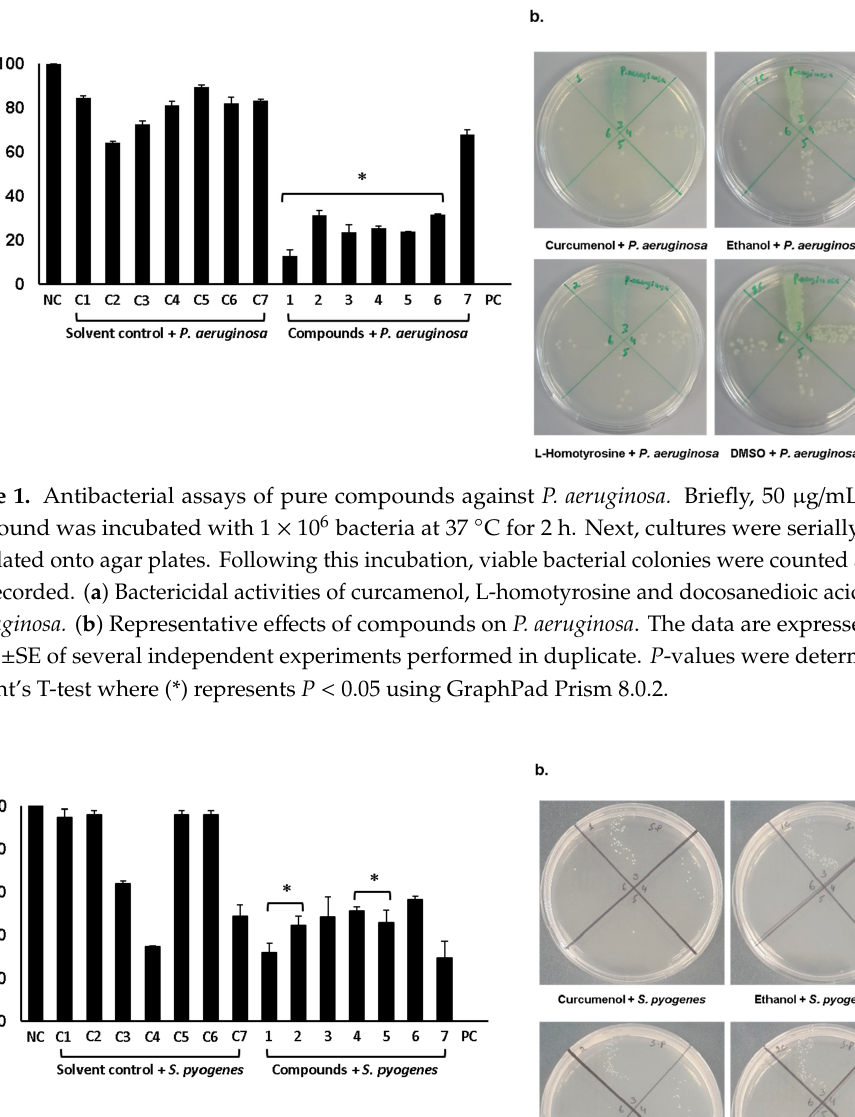
Figure 2. Antibacterial assays of pure compounds against S. pyogenes. Briefly, 1 × 10 6 bacteria were exposed to 50 µ g / mL of each compound at 37 ◦ C for 2 h. After this, cultures were serially diluted, plated onto agar plates and plates were incubated overnight at 37 ◦ C. Next day, bacterial c.f.u was determined by counting viable colonies. ( a ) Antibacterial activities of curcamenol, L-homotyrosine and docosanedioic acid against S. pyogenes. ( b ) Representative e ff ects of compounds on S. pyogenes . P -values were determined by student’s T-test where (*) represents P < 0.05 using GraphPad Prism 8.0.2. The data are expressed as the mean ± SE of several independent experiments performed in